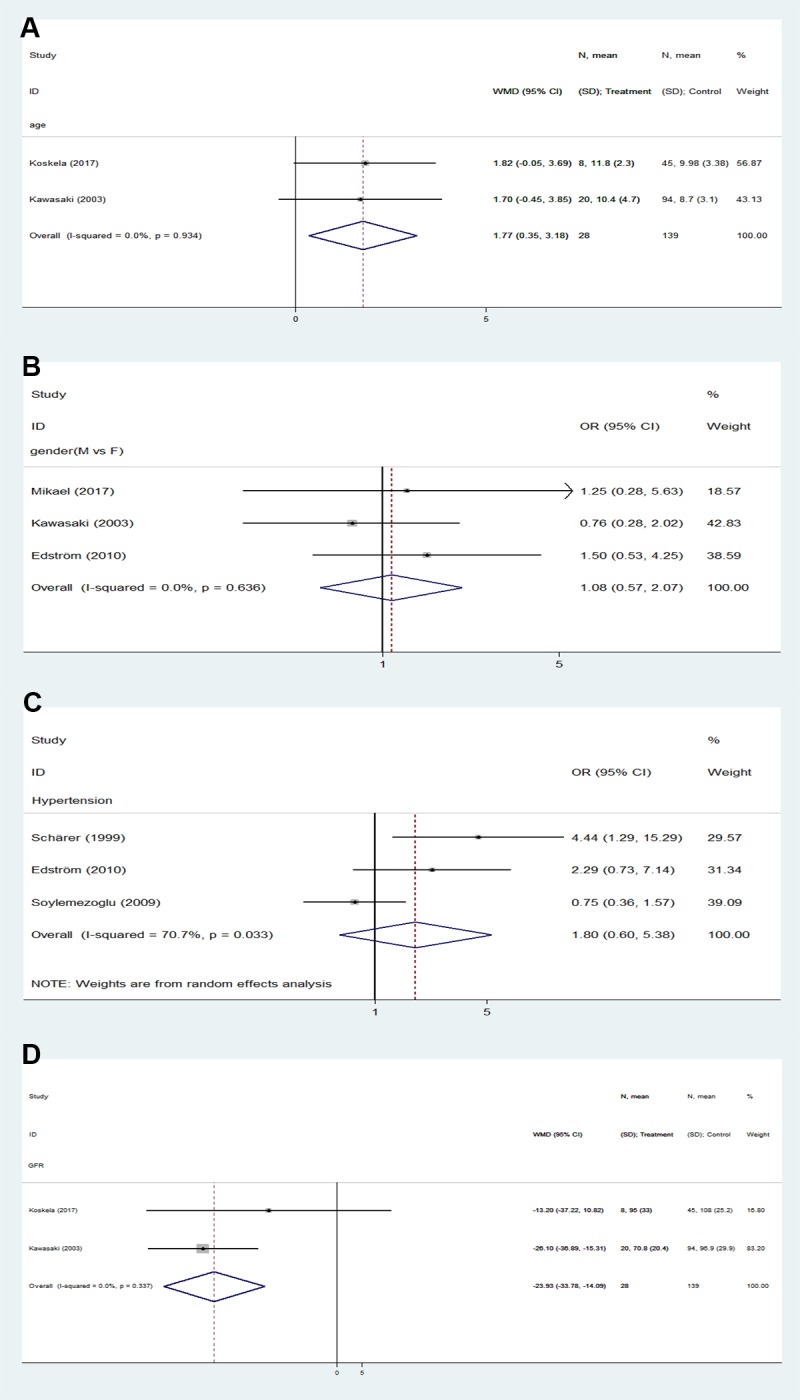
Forest plots of OR/WMD estimates for the following.(A) age. (B) gender (male vs. female). (C) hypertension. (D) level of GFR.